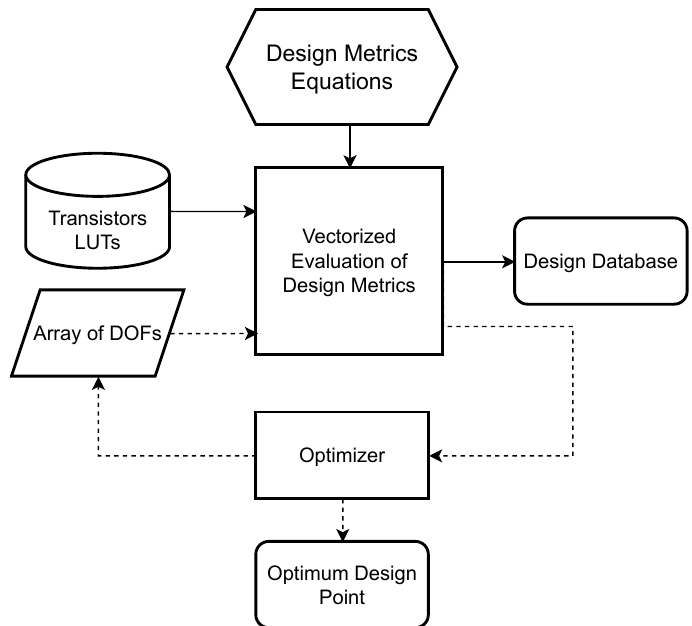
Figure 2. Design database generation